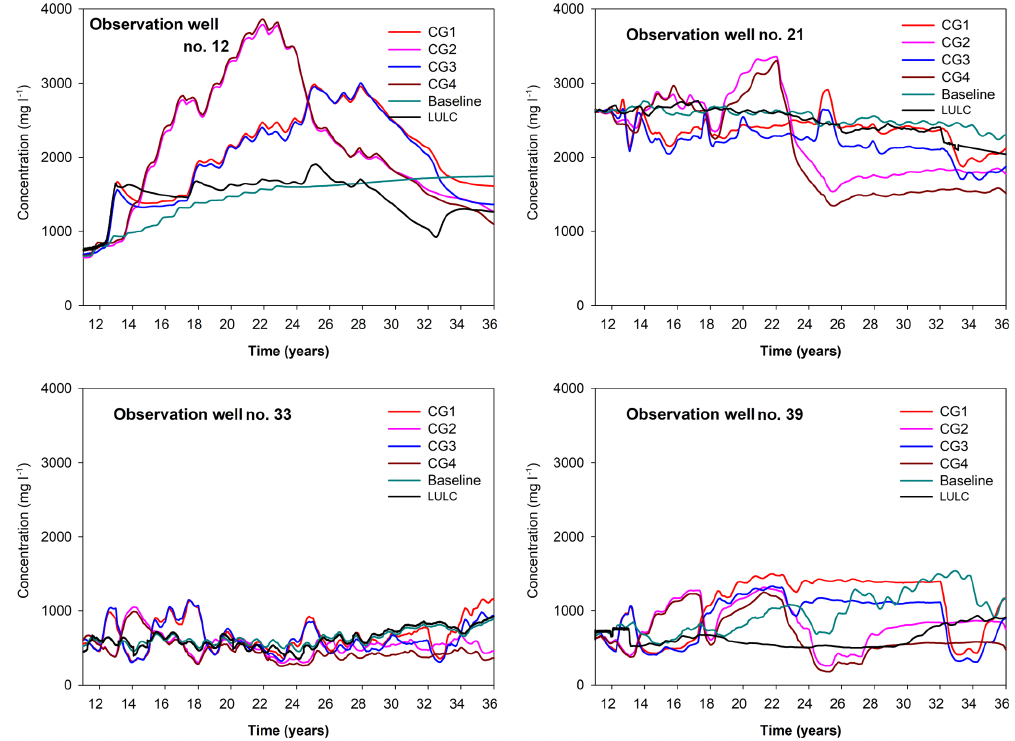
Figure 14. Evolution of future salinity concentrations at four observation points for the baseline (BL) scenario and the four global change